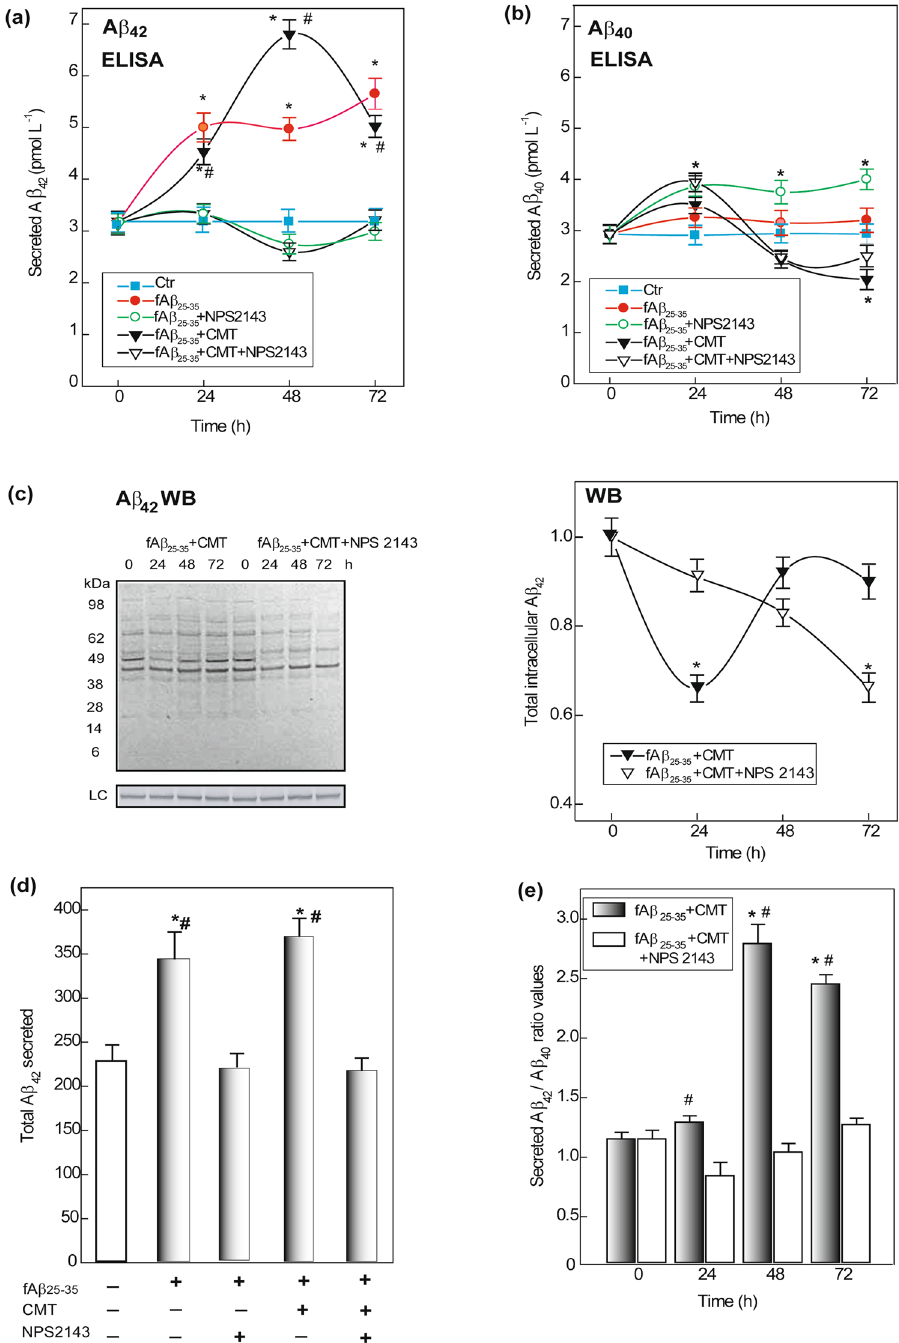
Figure 1. Changes in human astrocytes’ secreted and intracellular amounts of endogenous A β 42 and A β 40 . (a) A β 42 peptides secreted amounts increase after an exposure to fA β 25 − 35 ± CMT, but stay unchanged when NPS 2143 is also added. Points on the curves are means ± SEM of 3–5 independent experiments; fA β 25–35 + CMT ± NPS 2143: one-way ANOVA analysis of the complete data set F = 140.805, P < 0.001. Bonferroni t-test : comparisons of each treated group versus 0-h group (controls): * P < 0.05; pair-wise comparisons between corresponding treatments ± NPS 2143 at each time point: # P < 0.05. (b) Changes in A β 40 released amounts according to the treatments. Points on the curves are means ± SEM of 3–5 independent experiments; fA β 25–35 + CMT ± NPS2143: one-way ANOVA analysis of the complete data set F = 13.871, P < 0.001. Bonferroni t-test : comparisons of each treated group versus 0-h group (controls): * P < 0.05. (c) Left panel . Typical immunoblot revealing the changes in intracellularly accumulated A β 42 /A β 42 -os versus untreated controls according to treatments. LC, loading control. Right panel . Densitometric evaluations of the whole sets of intracellular A β 42 bands at each time point. Points on the curves are means ± SEM of 3 independent experiments, with control values normalized as 1.0. One-way ANOVA analysis of the complete data set F = 3.933, P < 0.012. Bonferroni t-test : comparisons of each treated group versus 0-h group (controls): * P <